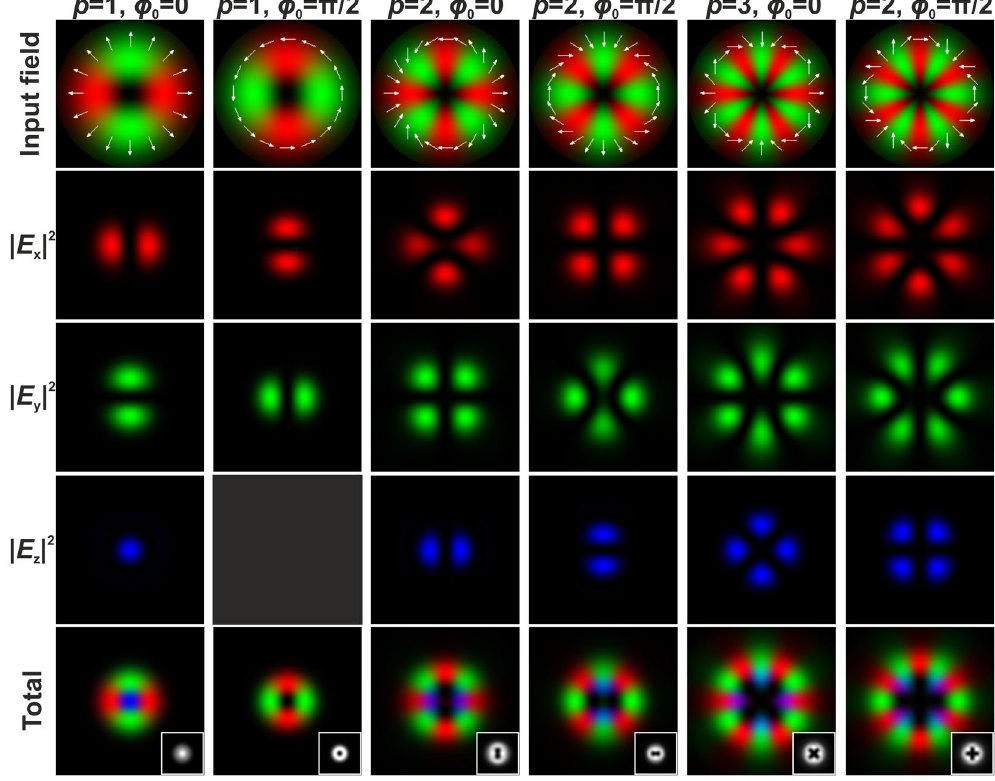
Figure 1. The distribution of the various components of the electric field in the focal plane of a focusing system (NA = 0.99) for an incident CVB with different positive polarisation order p and different inner polarisation rotation of the beam φ 0 . The insets in the total field distribution images show the generated grayscale intensity distributions. The white arrows show the schematic polarisation